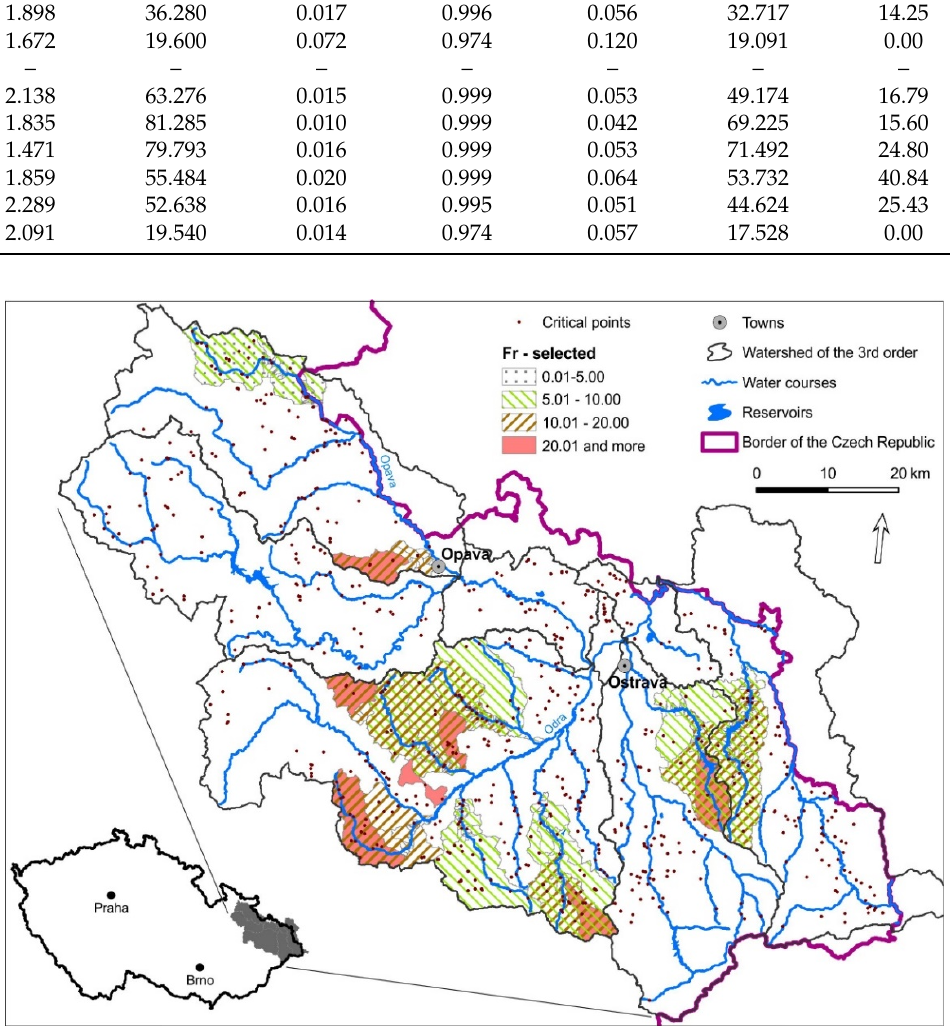
Figure 10. Selection of localities (group of watersheds 201-202-203) according to testing criterion (5) and sections of watercourses in areas of significant flood risk.